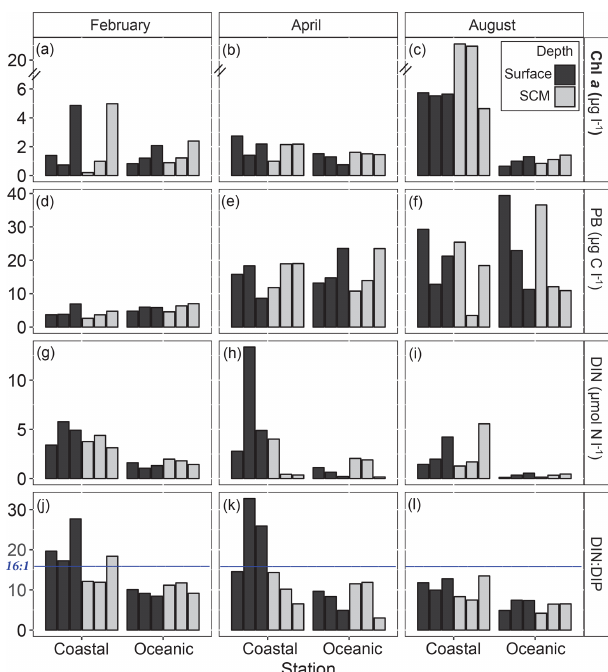
Figure 3. Initial biological conditions and abiotic factors at the coastal and oceanic sampling stations. Each bar corresponds to one of the three experiments performed at each depth and station during February, April and August. (a, b, c) Chl a , total Chl a (µgL − 1 ); note that the y axis is broken. (d, e, f) PB, prokaryote biomass (µgCL − 1 ). (g, h, i) DIN, dissolved inorganic nitrogen (µmolL − 1 ). (j, k, l) DIN:DIP, inorganic nitrogen:phosphate ratio. The blue line shows the Redfield ratio (16 : 1) and SCM refers to the subsurface chlorophyll maximum. Chl a : chlorophyll a concentration.